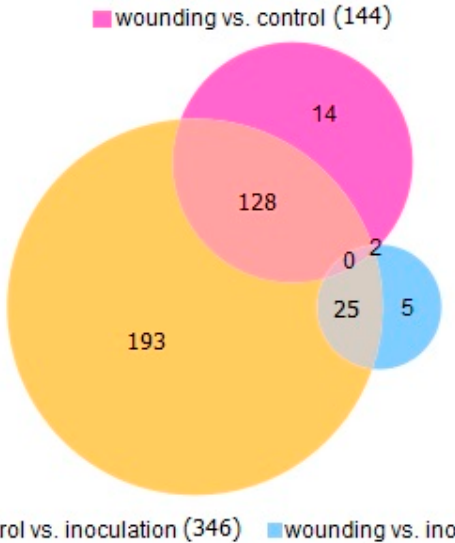
Figure 1. Number of DEGs depending on treatment.